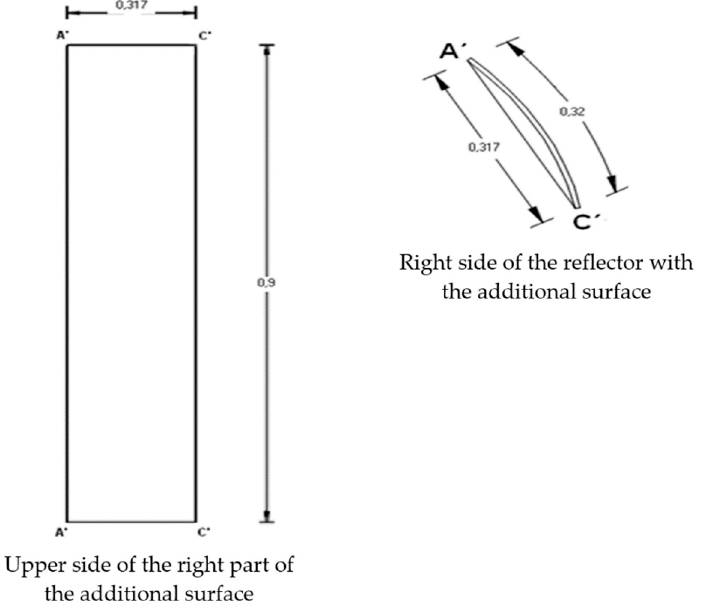
Figure 8. Dimensions (in m) for the additional surface, which will be hypothetically located in the right part of the reflector (CAD environment).